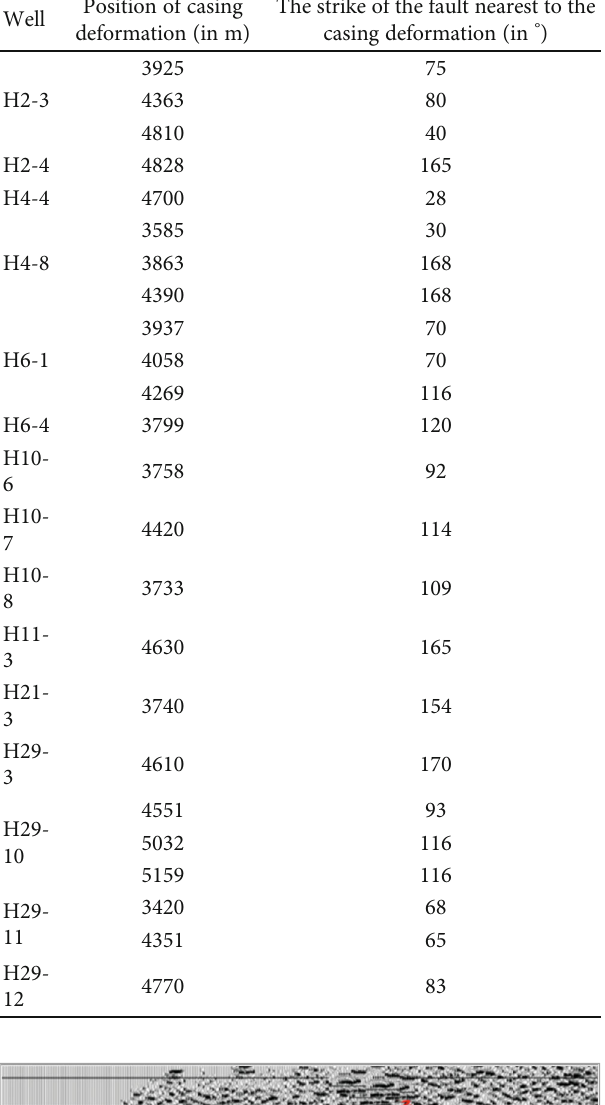
Table 2: Summary of casing deformation position and fault strike in the Ning209 block.